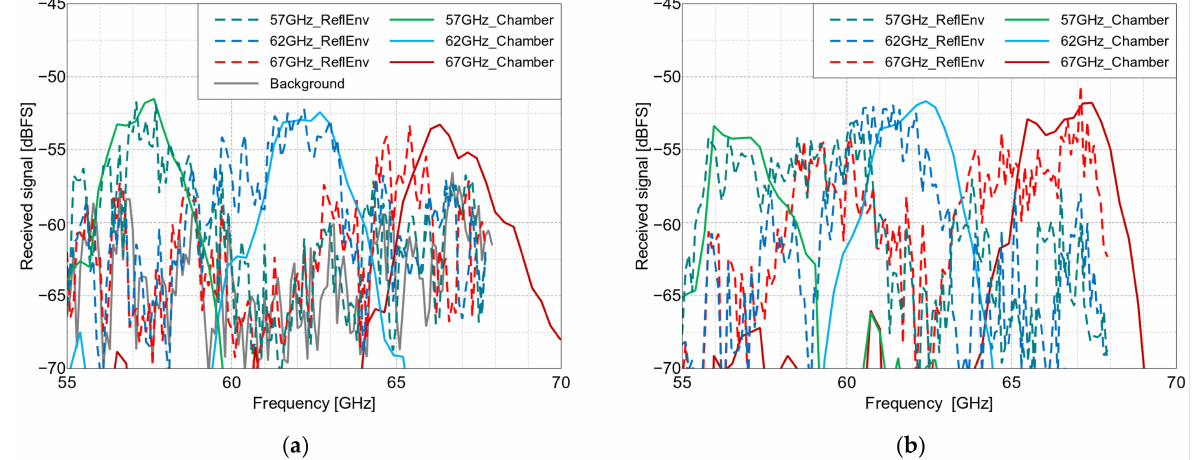
Figure 13. The measured received signal level in the NI measurement setup with the cross-polarized arrays placed on a door, vs. the frequency, at angles of incidence of: ( a ) 0 ◦ and ( b ) 30 ◦ . ReflEnv— measurement in the reflective environment and Chamber—normalized anechoic chamber measure- ment results for visual reference. The resonance frequencies of the three manufactured Van Atta tags (in GHz) are 57, 62 and